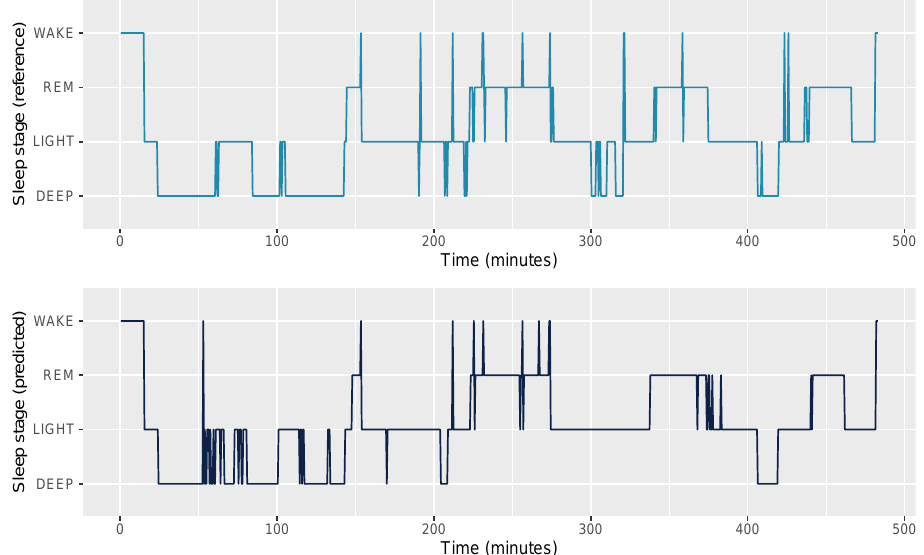
Figure 13. Example hypnogram for an average night (f1 = 0.78) for the model, including all features